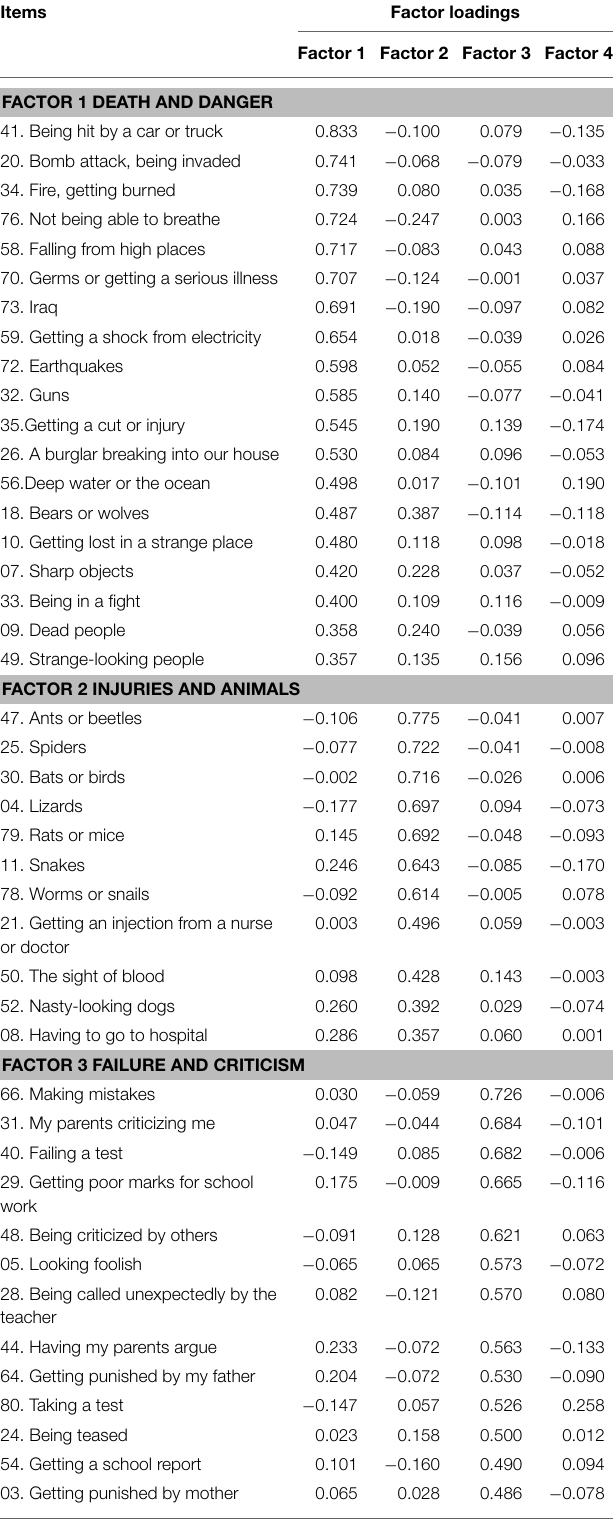
TABLE 1 | Questionnaire items and corresponding factor loadings from the EFA rotated pattern matrix.